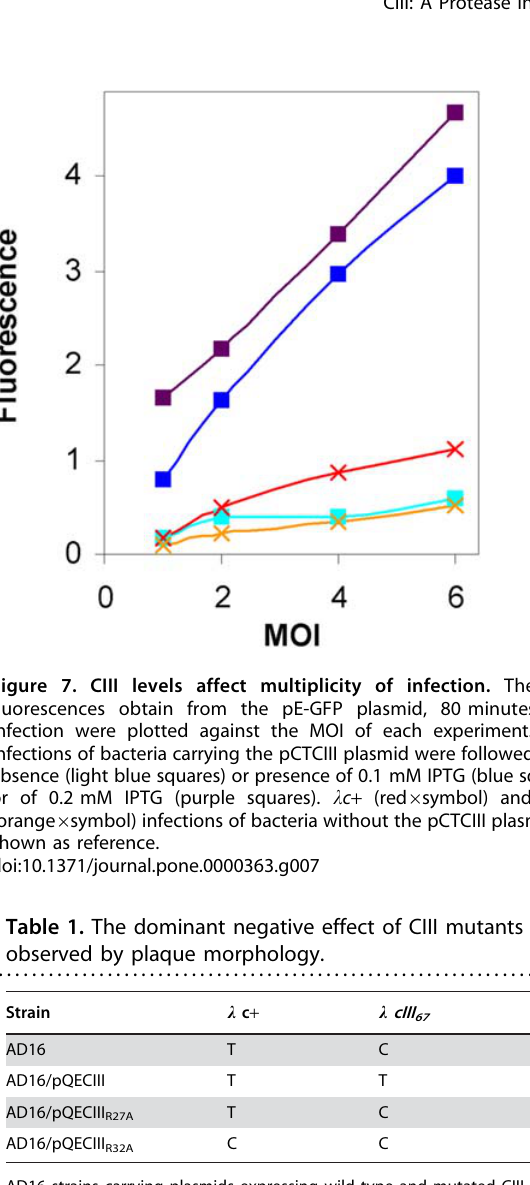
phages indicated in the table. C-clear plaques, T-turbid plaques. doi:10.1371/journal.pone.0000363.t001 Table 2. CIII-GFP plasmid inhibits bacterial growth. ... ... ... .... ... ... .... ... ... .... ... ... .... ... ... .... ... ... .... ... ... . Strain